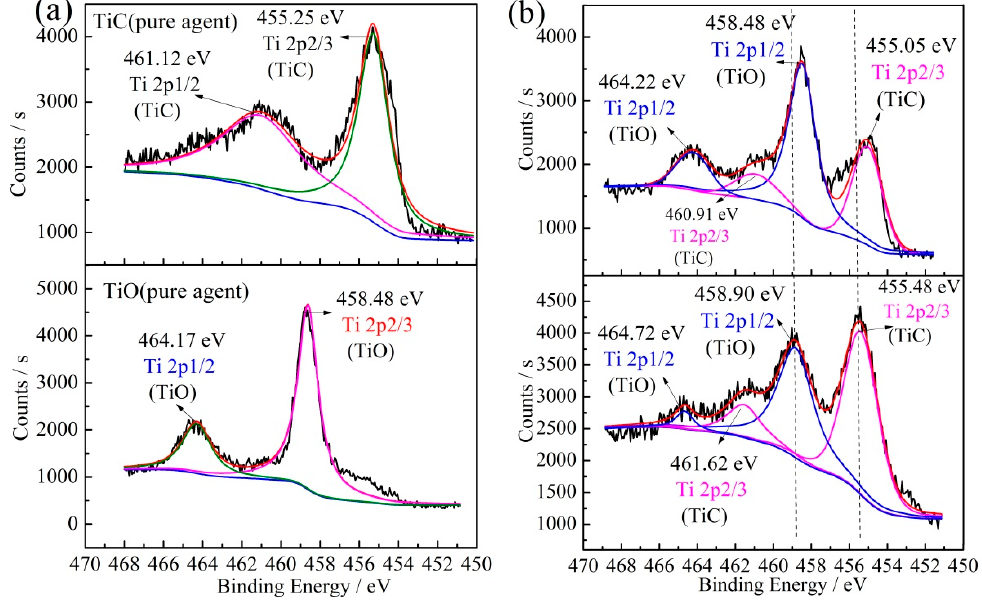
Figure 5. ( a ) Ti 2P spectra of pure TiO and TiC reagents, ( b ) Ti 2P spectra of a mixture of TiO and TiC (molar ratio of 1:1) before and after sintering (1550 °C under argon for 4 h sintering). As can be seen from Figure 5b, Ti 2p3/2 and Ti 2p1/2 of the mixture of TiC and TiO (1:1 mole ratio) are different before and after sintering, such that the peak of Ti 2p before sintering is low on the left and high on the right; whereas this peak was high on the left and low on the right after 4 h sintering, confirming that TiC x O y solid solution would be formed after sintering. Therefore, according to the shape of Ti 2p3/2 and Ti 2p1/2 com- bined with the result of XRD, it can be judged whether the reduction product is TiO, TiC x O y or TiC. Subsequently, Ti 2p peaks can be utilized to determine the characteristics of TiO and TiC. (2) XPS Spectra of the Reduction Products of Samples No. 9–14 The Ti 2P spectra of the reduction products of samples No. 9–14 are shown in Figure 6a–f, respectively. If the phase in No. 9 be judged only from the XRD characteristic peak at the 2 θ value of 42.42°, then the main phases would be Fe, Ti 2 O 3 and TiO. However, from analysis of Ti 2P in Figure 6a, it can be envisaged that the Ti 2p3/2 of TiC also ap- pears at 455.43 eV (Ti-C), indicating that TiC x O y would be the reduction product when Ti:C is 1:2.5. The shape of Ti 2P spectra in Figure 6b–d is similar to that in Figure 5b, and Ti 2p3/2 peak of TiC has been obviously appeared at 455.06, 455.20 and 455.30 eV, indi- cating that TiC x O y is the main reduction product of samples 10–12. When Ti:C ratio is 1:3, 1:3.5 and 1:4, the reduction product is TiC x O y and Fe. The shape of Ti 2P spectra in Figure 6e,f is similar to that of pure TiC reagent and Ti 2p3/2 peak of TiC is prominent. When Ti:C ratio is 1:5 and 1:6, all titanium content is reduced to TiC.